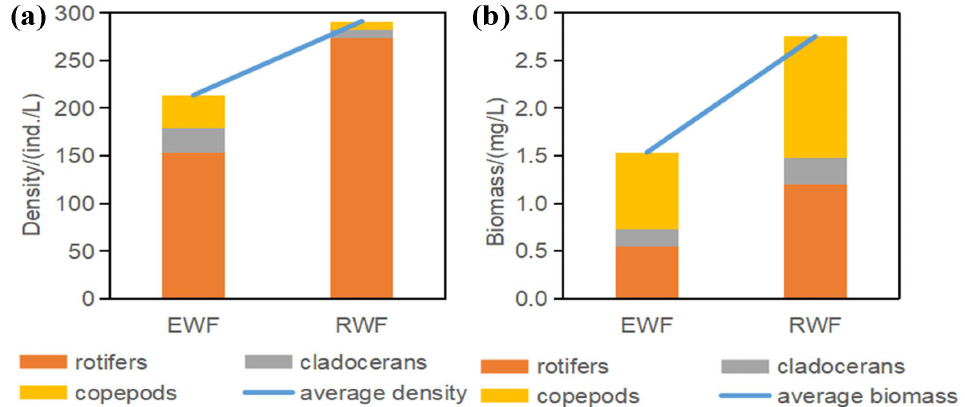
Figure 2. Zooplankton density ( a ) and biomass ( b ). Abbreviations used in the diagram: EWF, extreme water level fluctuation period; RWF, regular water level fluctuation period.